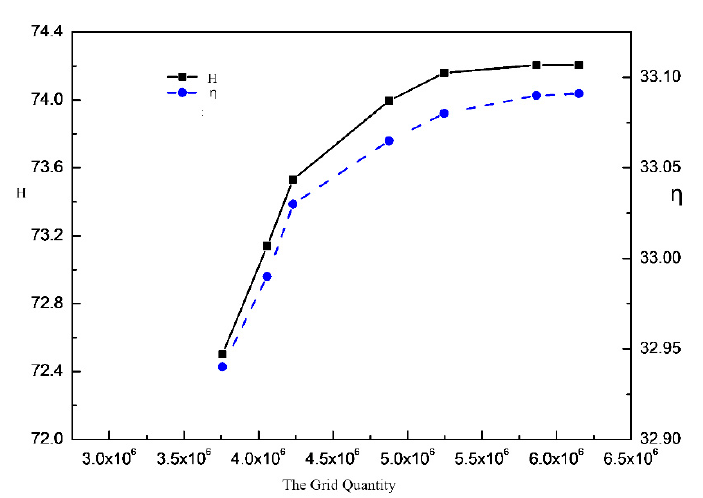
Figure 5. The grid independence verification.